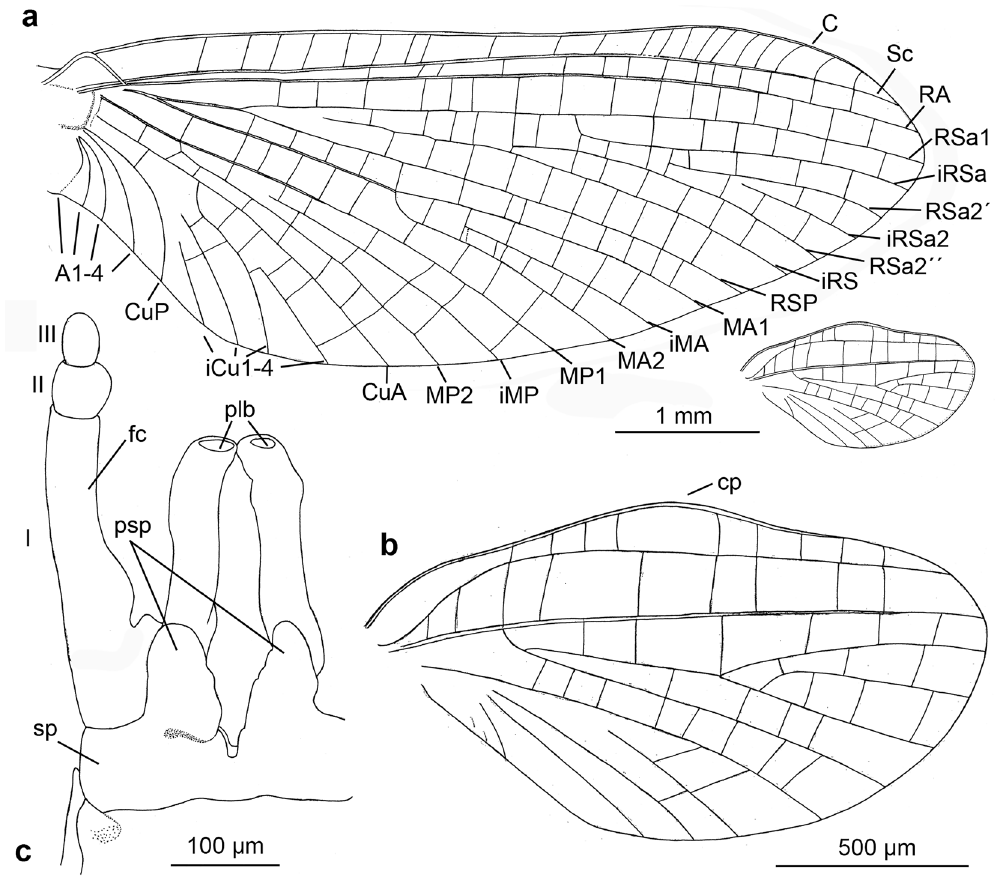
Figure 2. Calliarcys antiquus sp. nov., holotype, male imago; Eocene Baltic amber; BB 2515 [SMNS coll.]; ( a ) fore- and hind wings (wing proportions are preserved), ( b ) enlarged hind wing, ( c ) genitalia in ventral view; fc—forceps; I-III—forceps segments; plb—penis lobe; psp—projections of styliger plate; sp—styliger plate; cp— costal process. Nomenclature of wing veins used throughout the text is based on 37